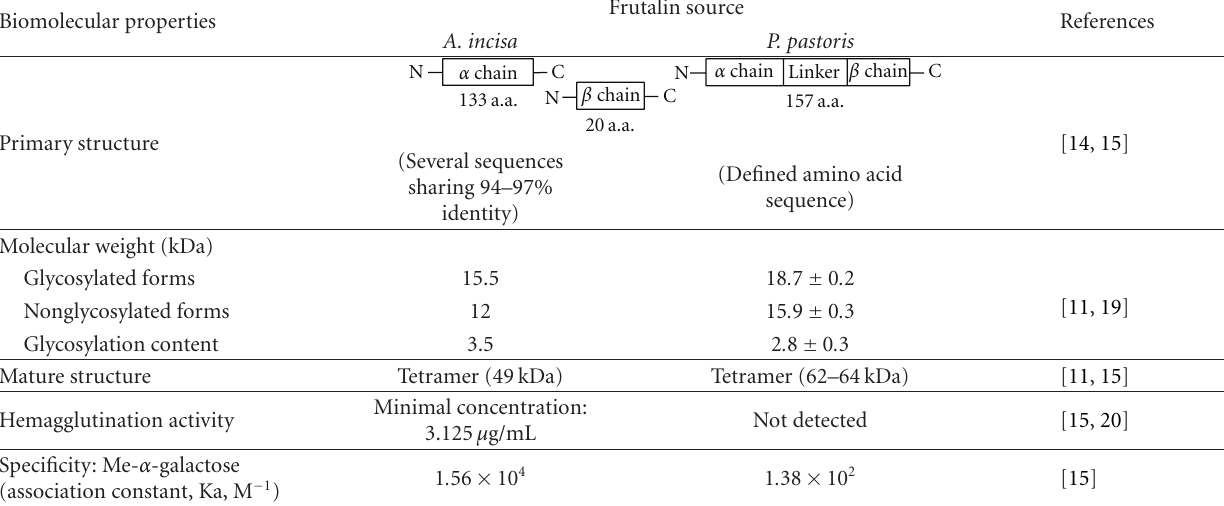
Table 1: Biomolecular properties of frutalin extracted from breadfruit seeds ( A. incisa ) (n-frutalin) and recombinant frutalin produced in P. pastoris